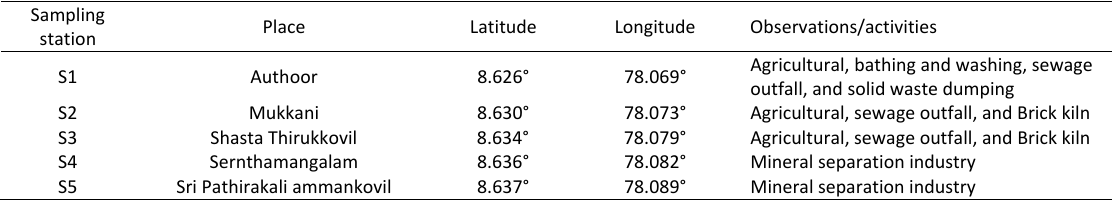
Table 1: Details of the sampling places in the Tamiraparani River Sampling station